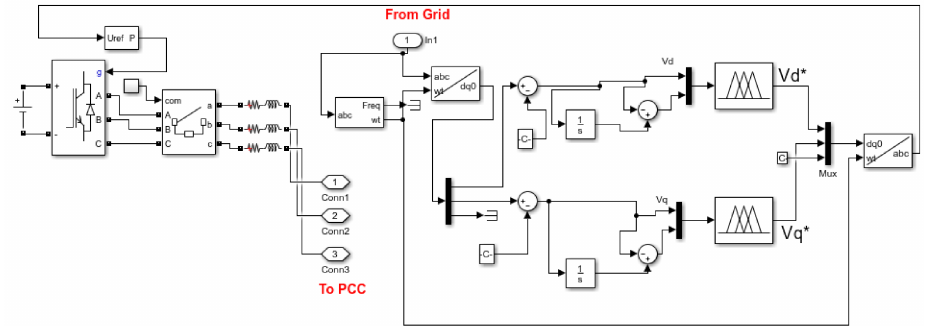
Figure 15. DVR control